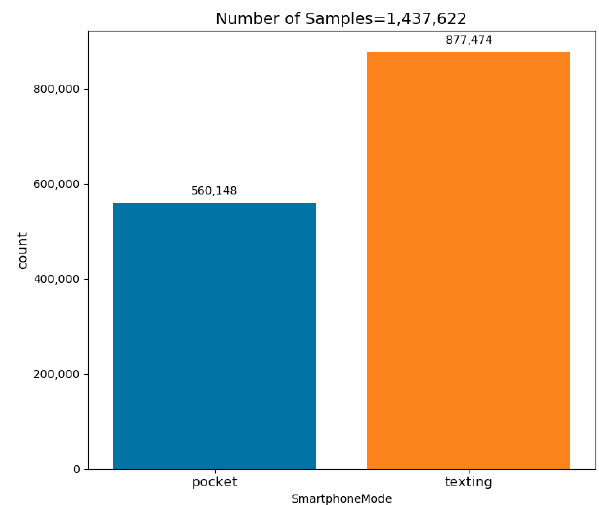
Figure A2. The RIDI dataset’s sample distribution to each smartphone location.